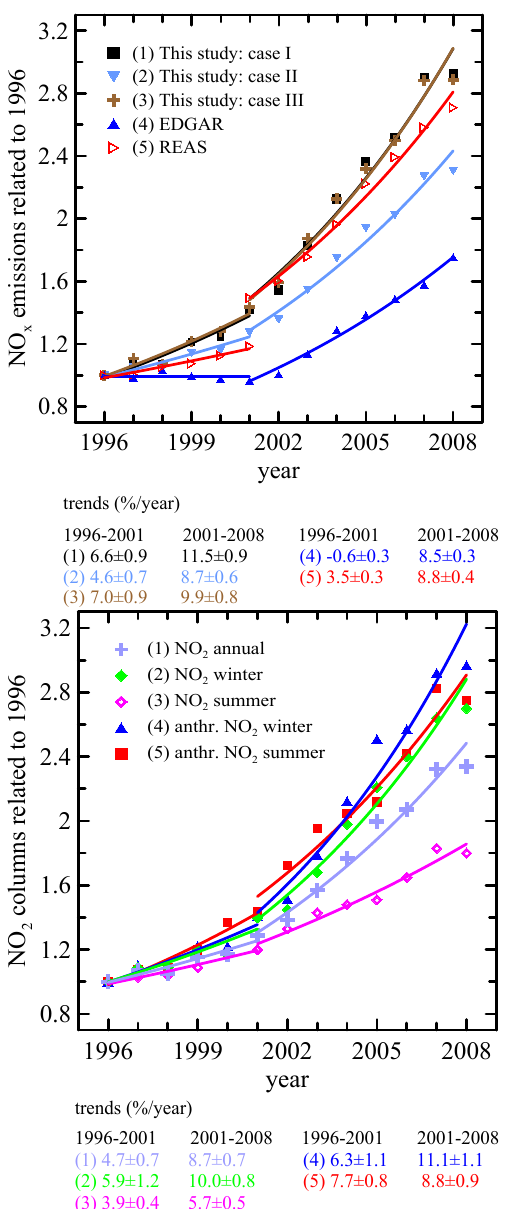
Fig. 5. (a) Multiannual exponential trends in the anthropogenic NO x emission in China (1–3) derived from satellite measurements in cases I–III of the estimation procedure, respectively, and (4, 5) evaluated using the EDGAR v4.2 and and REAS (v1.11 and v2.1) inventories along with (b) multiannual exponential trends in the measured tropospheric NO 2 columns averaged over East China (see Fig 3a) annually (1) and seasonally for the cold (2) and warm (3) seasons. Additionally, the plot (b) demonstrates the trends in the estimated anthropogenic part of the measured tropospheric NO 2 columns for the cold (4) and warm (5) seasons. Note that the REAS v1.11 and v2.1 data are shown for the periods from 1996 to 2001 and from 2001 to 2008, respectively. All the data are nor- malized to the values from